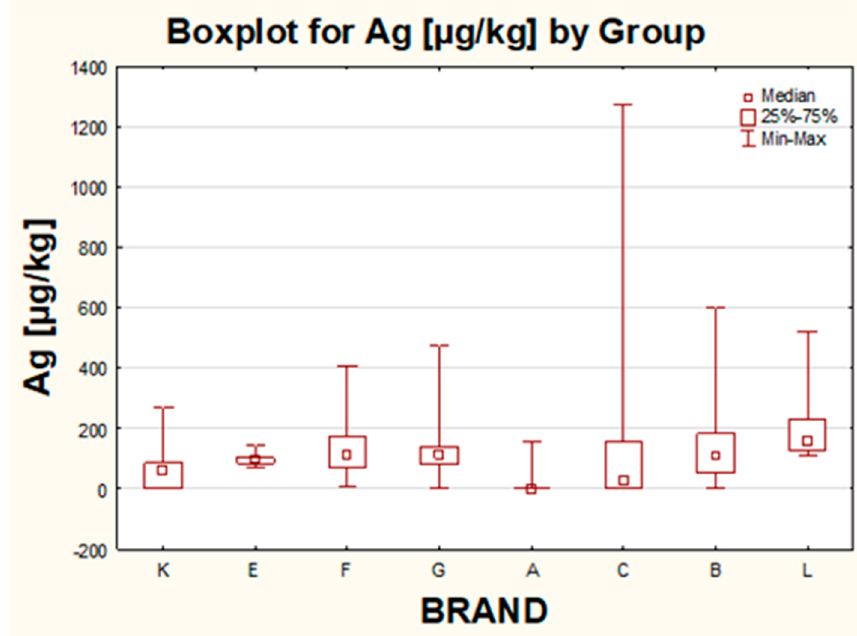
Figure 6. The box–whisker plots representing the influence of the company on the concentrations of Ag (µg/kg).